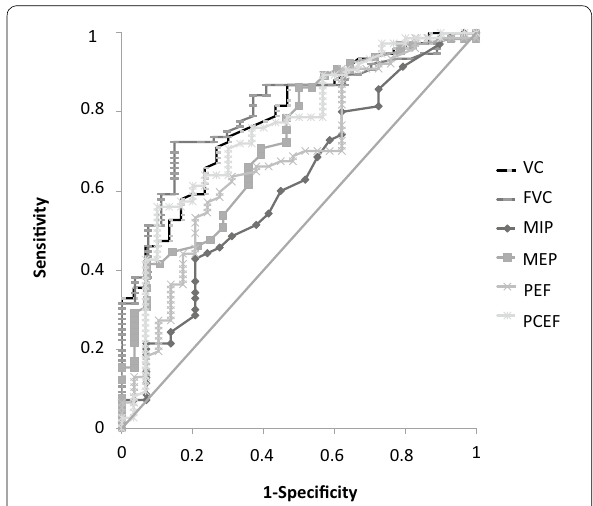
Fig. 3 Receiver operating characteristic (ROC) curves for data recorded after extubation: peak cough expiratory flow (PCEF), peak expiratory flow (PEF), forced vital capacity (FVC), slow VC, and maxi‑ mal inspiratory (MIP) and expiratory (MEP) mouth pressures AUC, area under the ROC